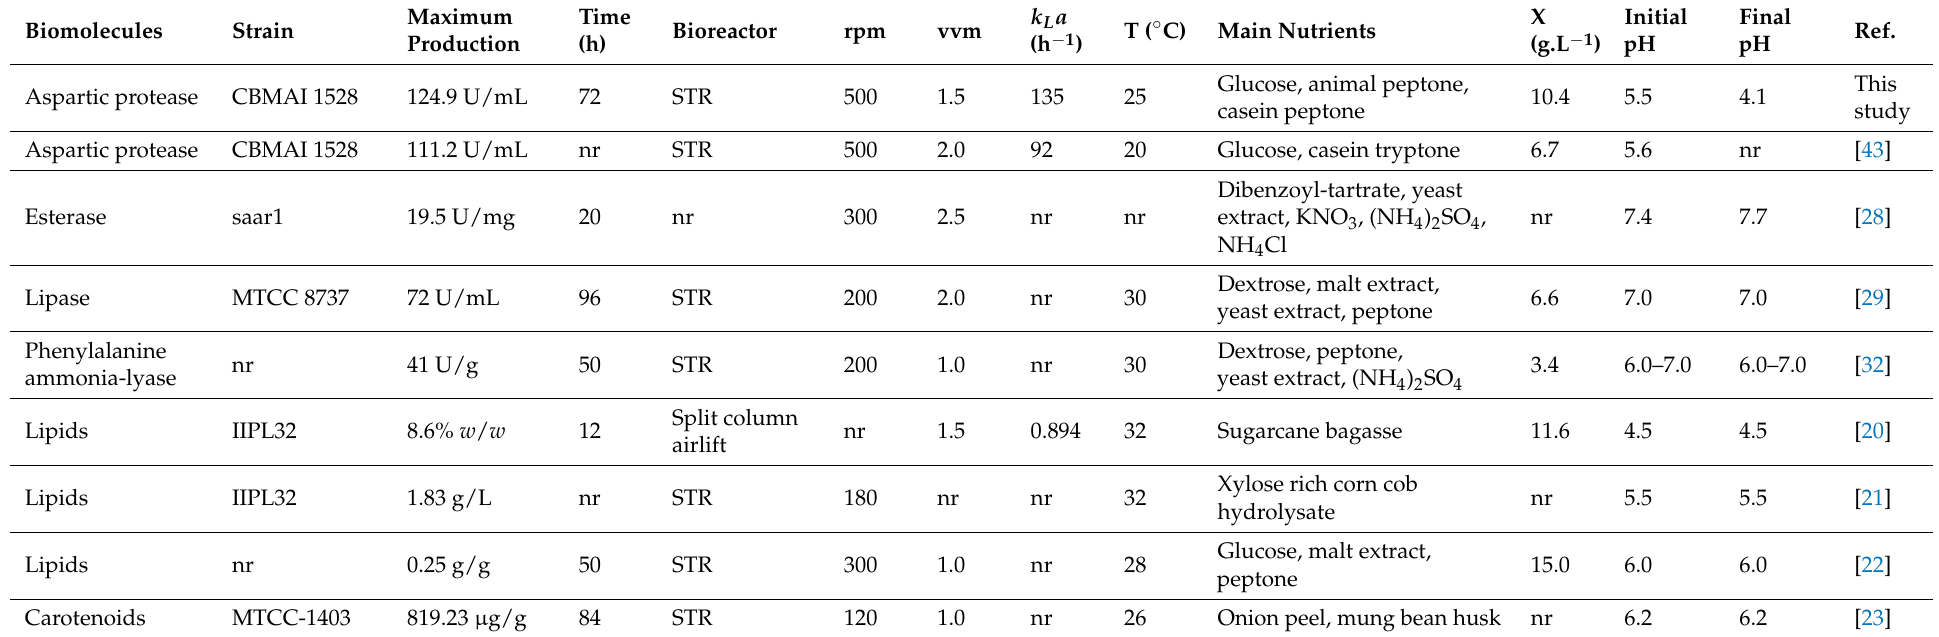
Table 6. Biomolecules production by Rhodotorula mucilaginosa strains in